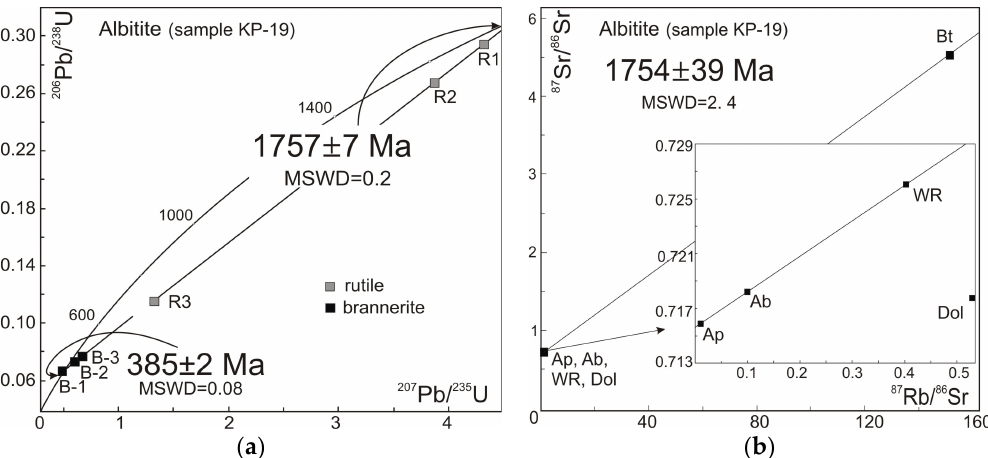
Figure 6. Isotope data for albitite of the Ozernoe area: ( a ) U-Pb Concordia diagrams for rutile and brannerite; ( b ) Rb-Sr isochron for whole rock (WR) and minerals: apatite (Ap), albite (Ab), dolomite (Dol).